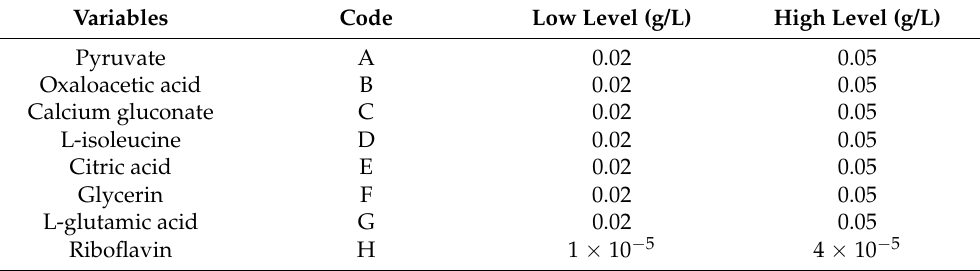
Table 2. Experimental design of eight independent variables and their coded values using the PBD.